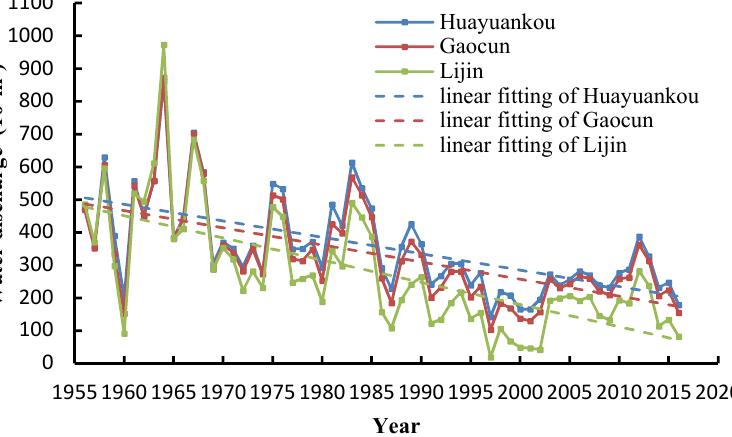
Figure 3. Variation trend of annual streamflow of the middle reaches in the Yellow River.